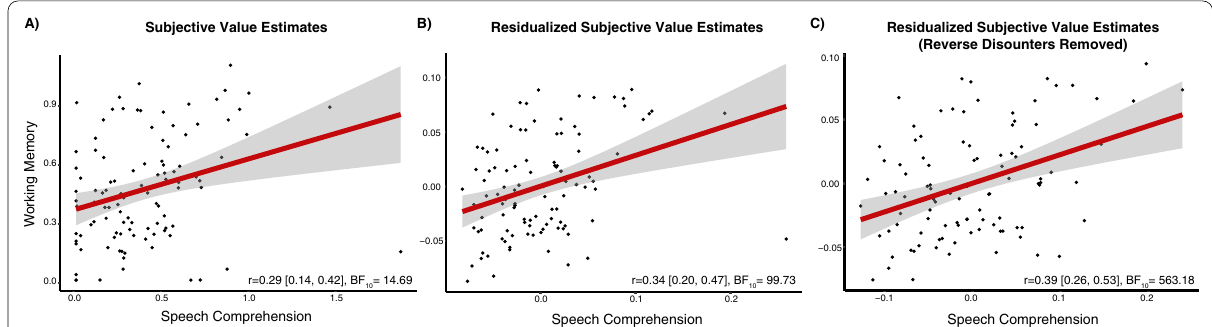
Fig. 2 a Zero-order correlation of average subjective value estimates across working memory and speech domains, including all participants. b Correlation of residualized average subjective value estimates across working memory and speech domains, including all participants, but after controlling for task load and individual differences in task performance, working memory capacity, and reward sensitivity. c Correlation of residualized average subjective value estimates across working memory and speech domains, after excluding participants who had an average subjective value > 1, and also controlling for task load and individual differences in task performance, working memory capacity, and